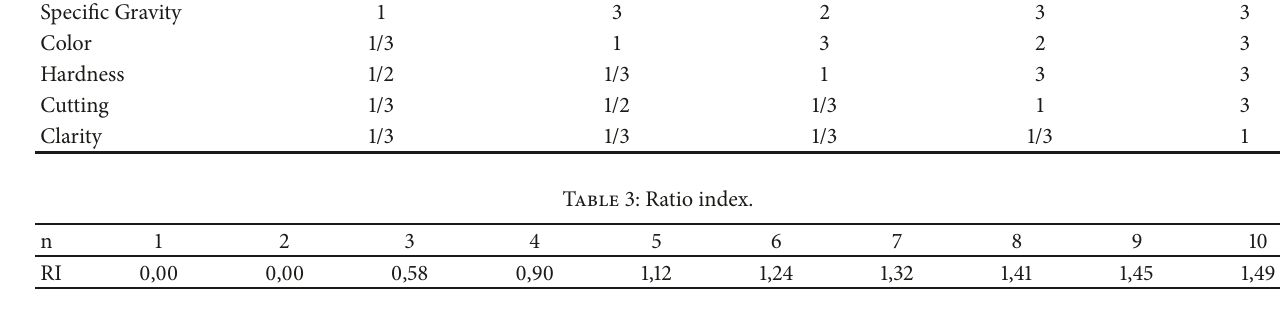
Table 4: Eigenvector on